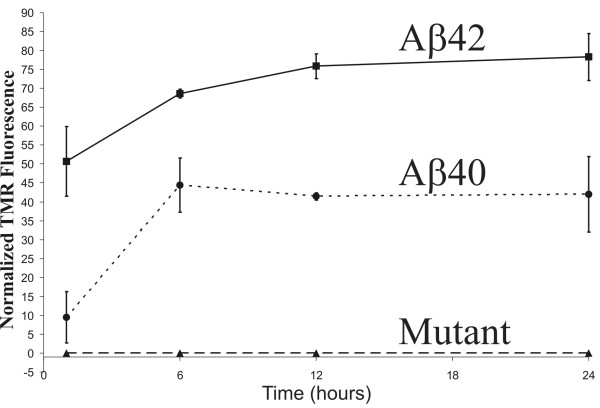
Average kinetics of TMR-labelled peptide association with live NGF differentiated PC12 cells. Aβ42 (solid line) revealed an initial rapid binding phase within the first hour, followed by a slower binding phase over the next 24 hours. Aβ40 (dashed line) did not display the initial rapid binding phase, but was otherwise similar to Aβ42. The mutant peptide (dotted line) did not interact with the live NGF differentiated PC12 cells. This finding suggests a correlation between aggregation propensity and cell association for Aβ.